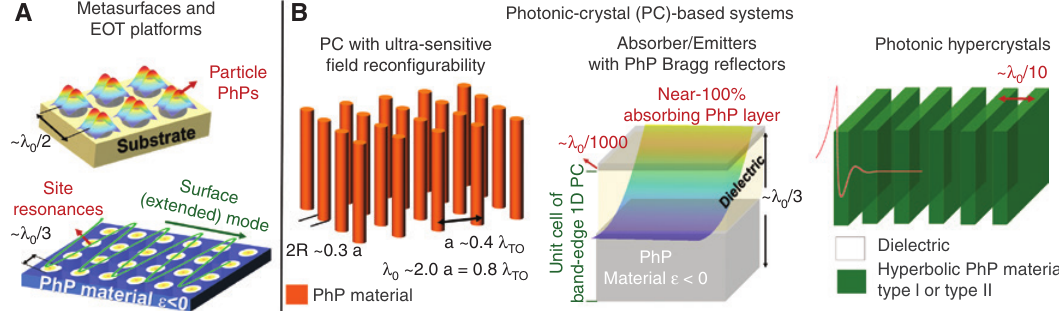
Figure 23: Examples of PhP-based mesophotonic platforms. (A) PhP analogues of metasurfaces and EOT platforms (e.g. see [87, 100]). (B) PC systems: (left panel) A PC made of PhP-material rods with overlapping photonic and PhP band gaps that exhibits extreme field re-configurability within an ultra-narrow spectral window around the TO phonon frequency (see [252]). (Middle panel) An ultra-thin PhP-material layer atop a PhP-material-dielectric Bragg reflector comprising only one unit cell acts like a frequency-selective near-perfect absorber (see [101]). (Right panel) A photonic hypercrystal: A 1D periodic system comprising alternating layers of a PhP natural hyperbolic crystal (e.g. sapphire) and a dielectric yields new types of low-loss ultra-confined interface states (see [238, 239]). Note that indicative feature/unit-cell size-ranges with respect to the free-space wavelength, λ stated targeted operation are given in all examples.